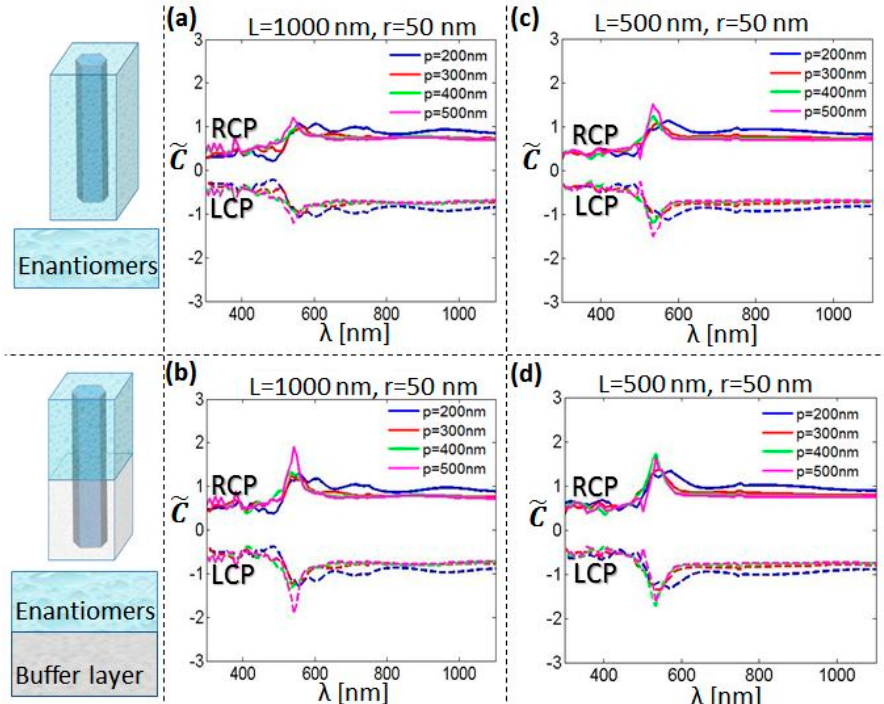
Figure 5. Normalized averaged C spectra for r = 50 nm, p = 200–425 nm, and RCP (full lines) and LCP (dashed lines) excitation. Upper and bottom sketches correspond to the integration from z = 0 nm to z = L, and z = L/2 to z = L, respectively. ( a ) L = 1000 nm, total integration; ( b ) L = 500 nm, total integration; ( c ) L = 1000 nm, half-integration; ( d ) L = 500 nm, half-integration.